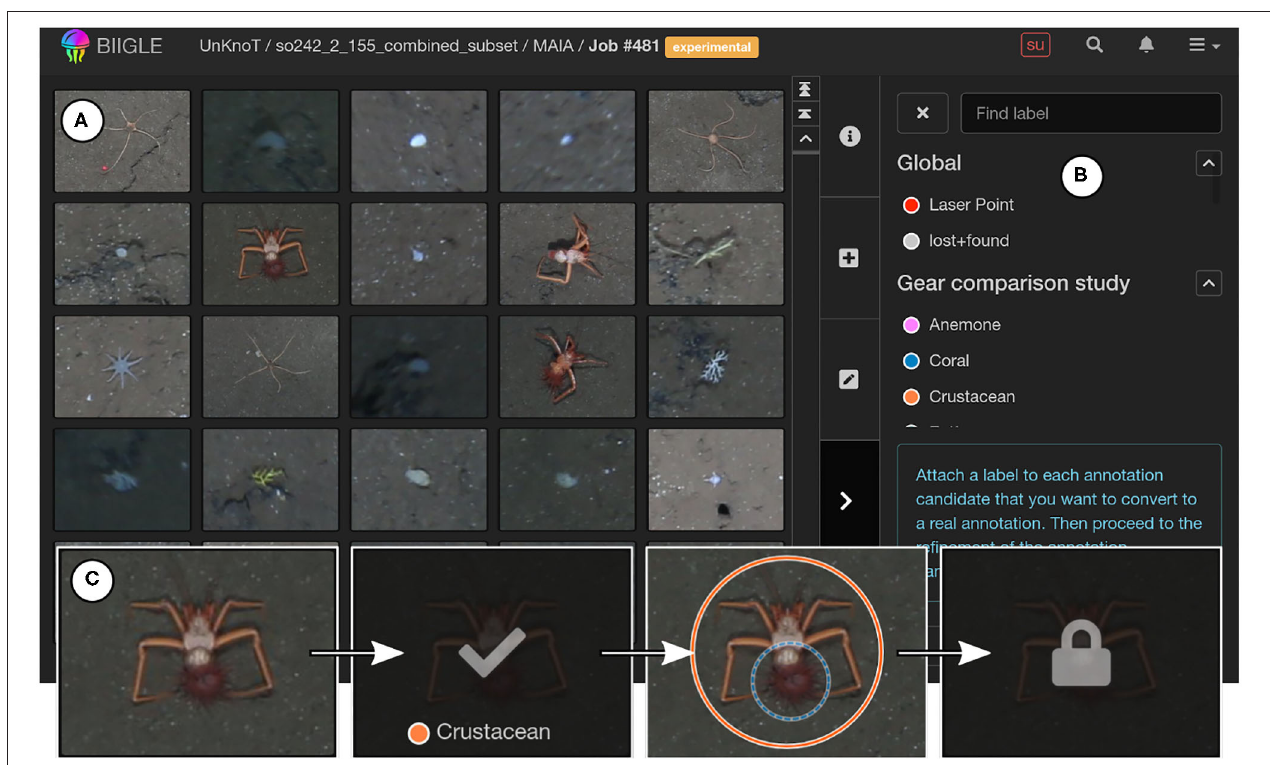
FIGURE 5 | User interface of MAIA in BIIGLE. (A) Training proposals and annotation candidates are shown as thumbnails in a large regular grid (this picture shows annotation candidates). (B) Labels to select annotation candidates can be chosen from a list of label trees in the sidebar. (C) Exemplary interaction with an annotation candidate thumbnail. First, the user inspects the candidate to identify an OOI. Next, the user selects the candidate with the appropriate label. Then the annotation candidate is refined in the original image to exactly mark the OOI (unselected annotation candidates are shown with a dashed outline). Finally, the candidate is converted to a real annotation and locked in the MAIA user